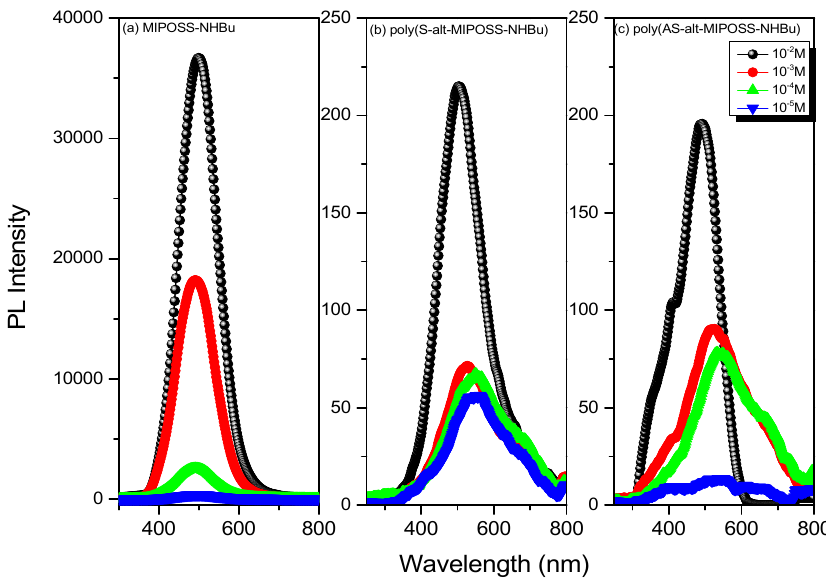
Figure 11. Fluorescence spectra of: ( a ) MIPOSS-NHBu monomer; ( b ) poly(S- alt -MIPOSS-NHBu); and ( c ) poly(AS- alt -MIPOSS-NHBu), in THF at concentrations from 10 − 5 to 10 − 2 M (excitation: 330 nm). The PL intensities of poly(S- alt -MIPOSS-NHBu) and poly(AS- alt -MIPOSS-NHBu) increased upon increasing the H 2 O content from 40% to 50%. We assign the decreases in the